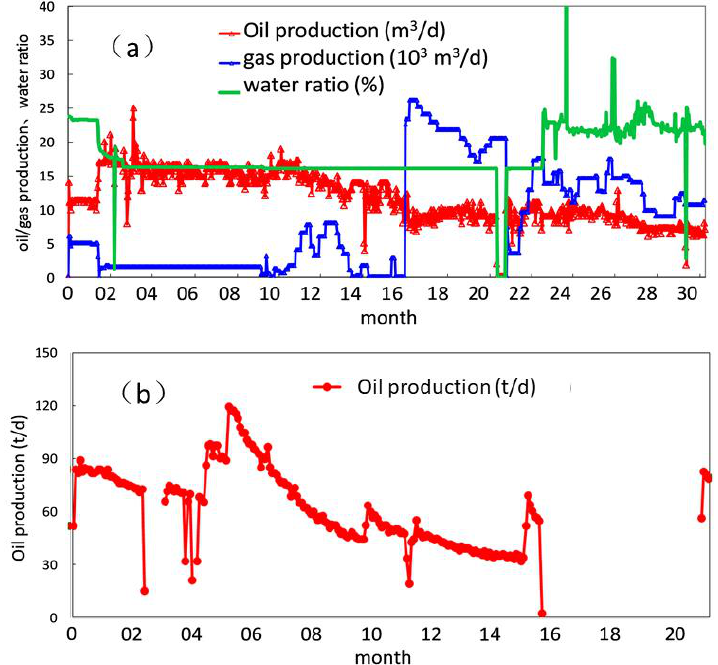
Figure 7. The typical production curves of the matrix reservoir ( a ) and fracture-cave reservoir in the oil production wells ( b ).